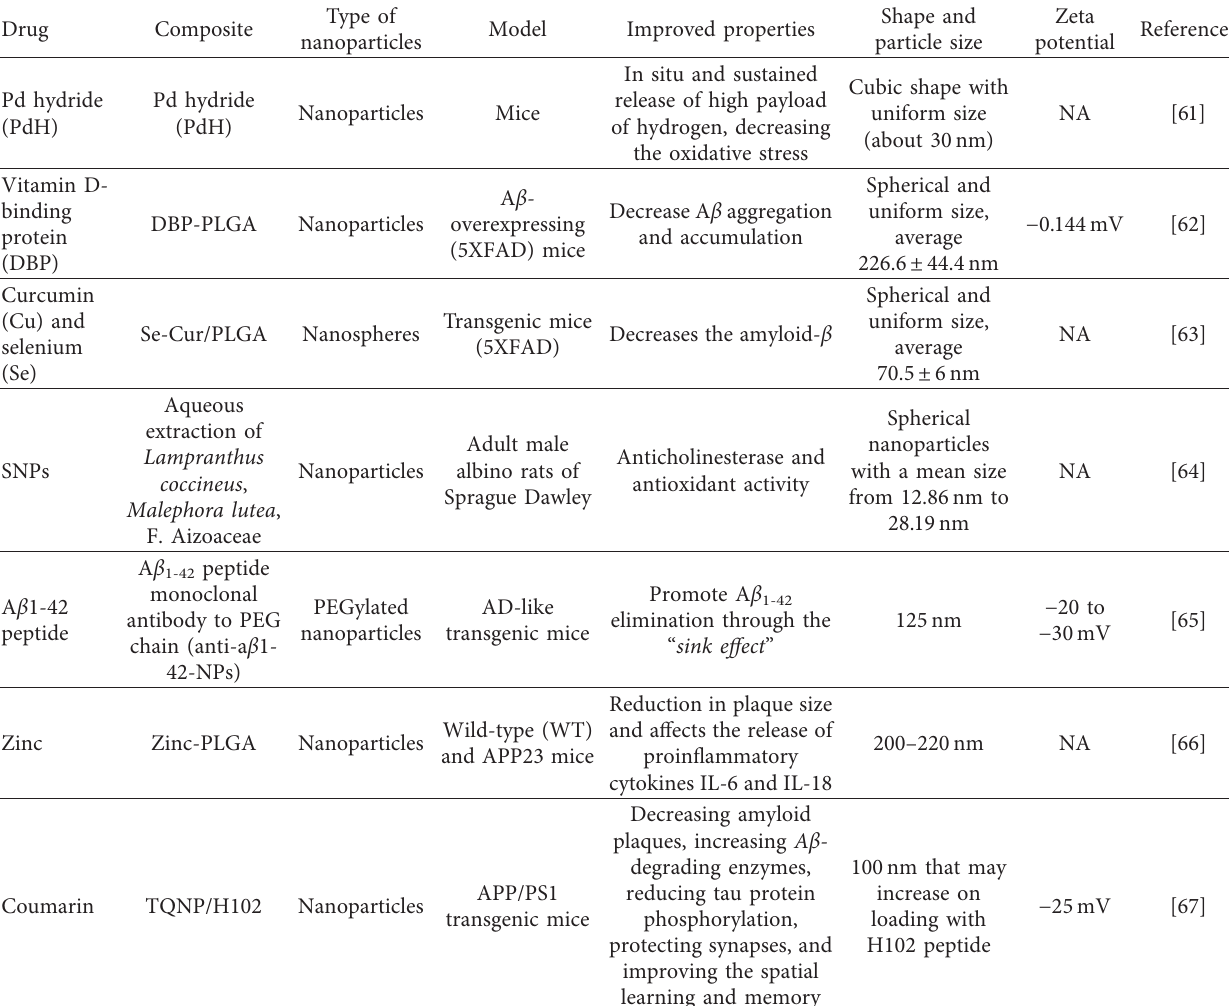
Table 1: Drugs used for investigating the effective therapy of different nanoparticles in the treatment of Alzheimer.